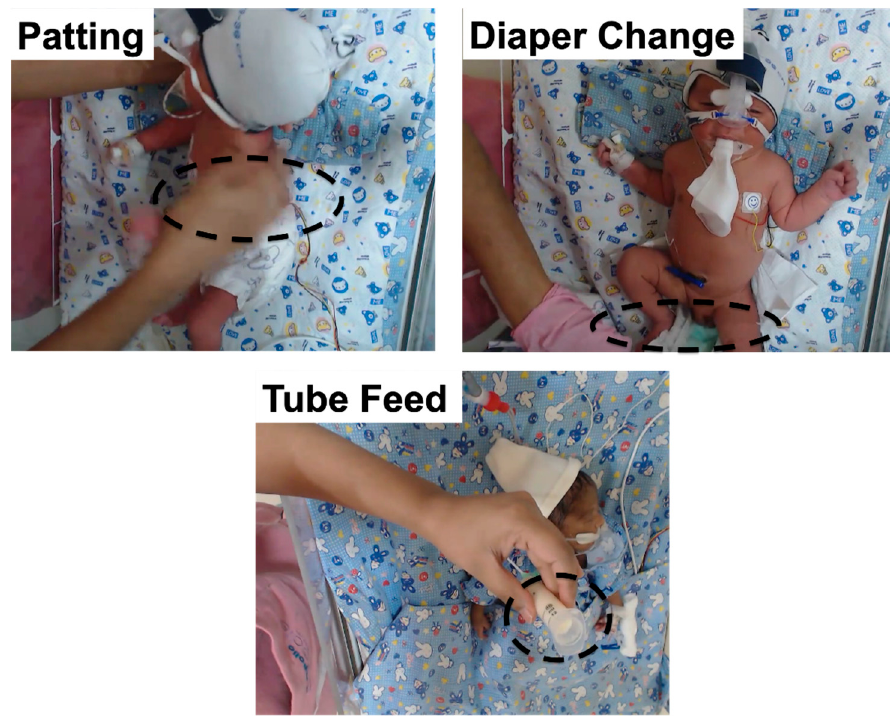
Figure 7. Automatic tagging of manipulation videos: The first frame identified as manipulation is marked on the top left, and dotted lines show manipulation. Table 5. Performance of deep learning model.